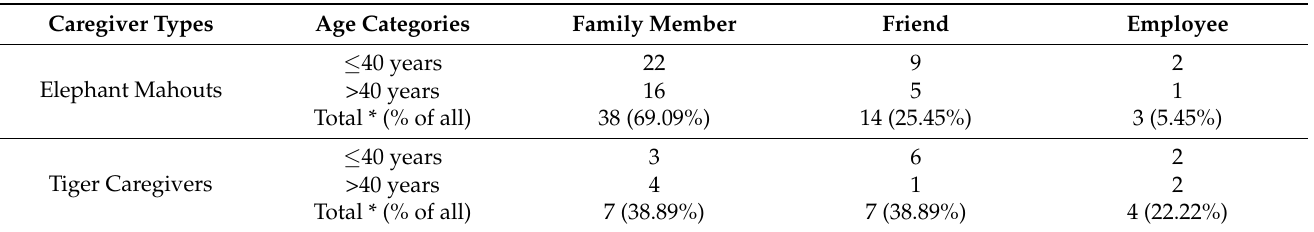
Table 4. Relationship with the animal reported by mahouts and tiger caregivers, as related to caregiver’s age.